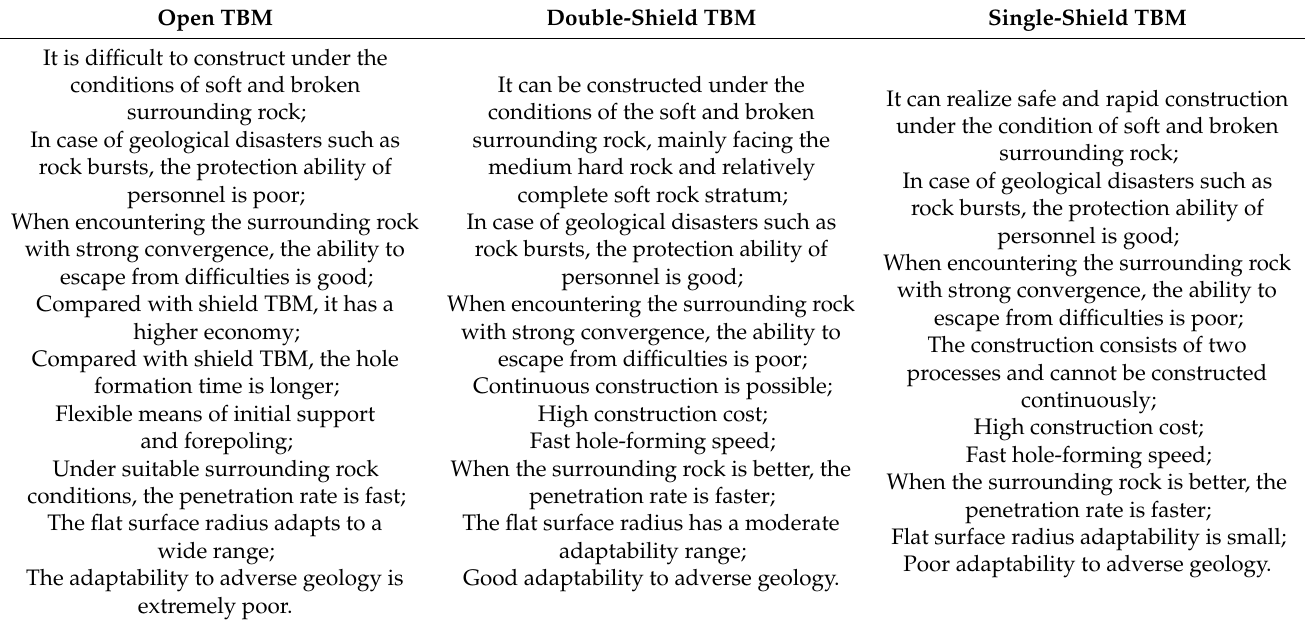
Table 3. Characteristics of various types of